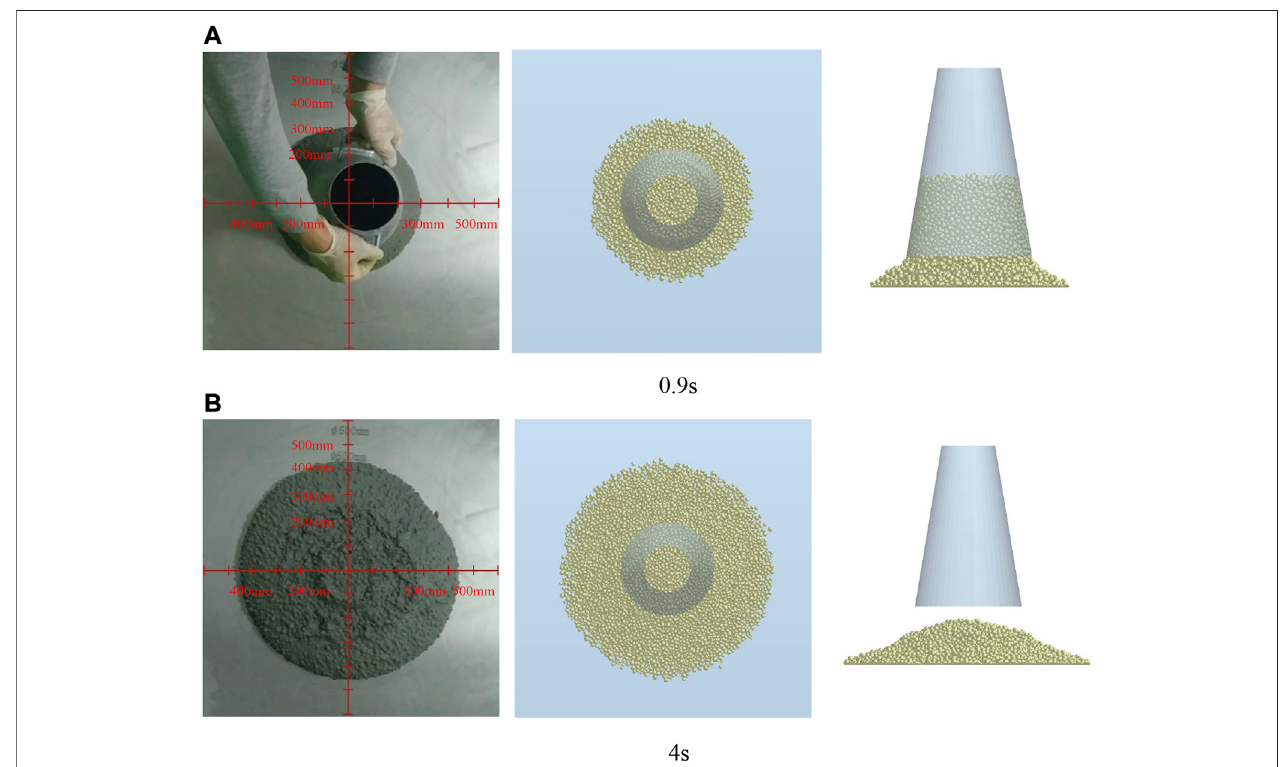
FIGURE 6 | Comparison between slump test process and DEM simulation of B1 concrete: (A) 0.9 s and (B) 4 s.